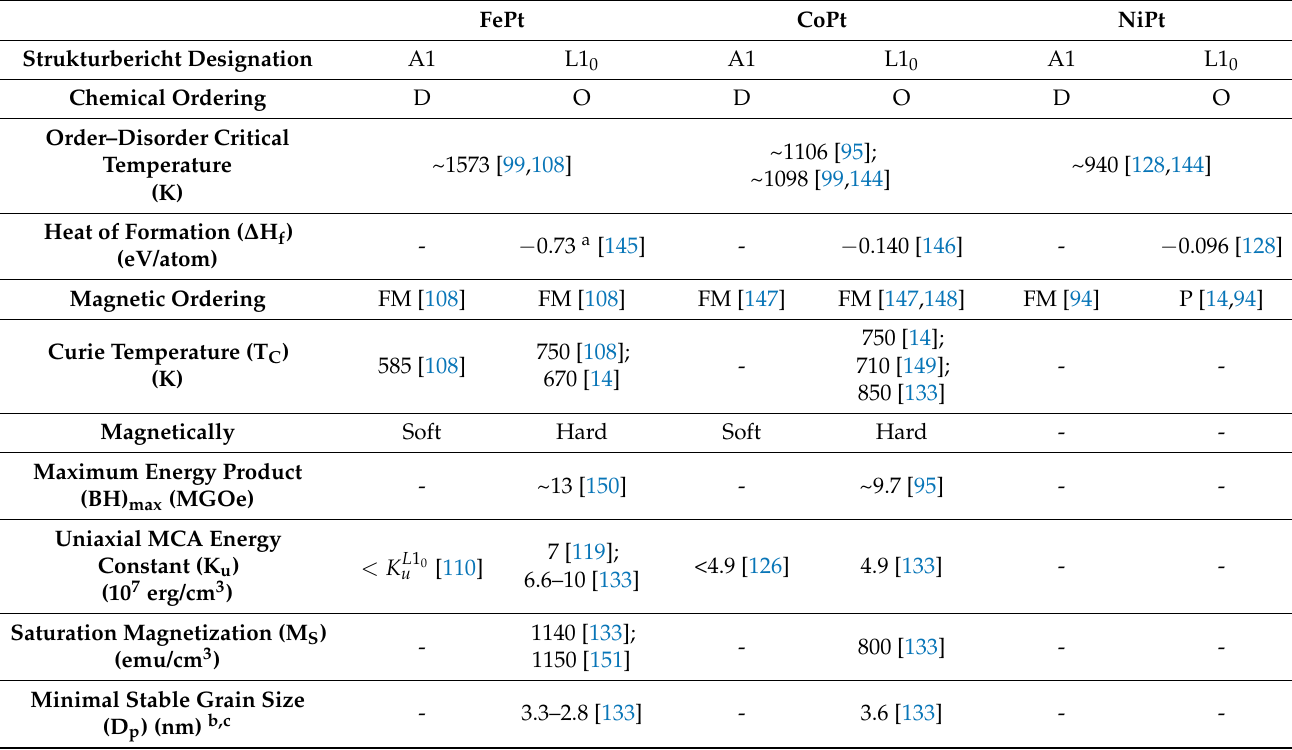
Table 2. Magnetic and structural properties of MPt (M = Fe, Co and Ni) bulk materials. O and D stand for chemically ordered and disordered phases, respectively. Magnetic ground states are indicated as FM (ferromagnetic) and P (paramagnetic). Magnetic quantities are reported in the centimeter/gram/second system